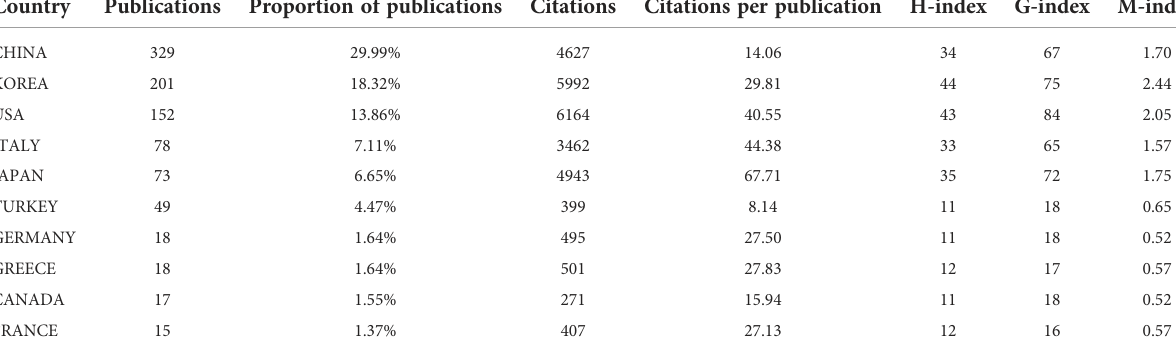
TABLE 1 Top countries and institutions in PTMC fi eld. Country